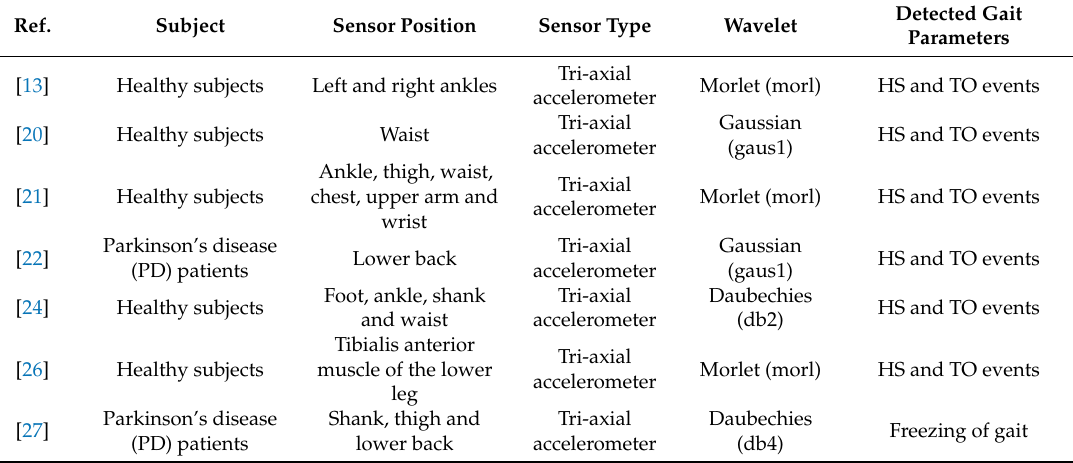
Table 1. A brief summary of some previous studies for gait event detection based on wavelet transforms.